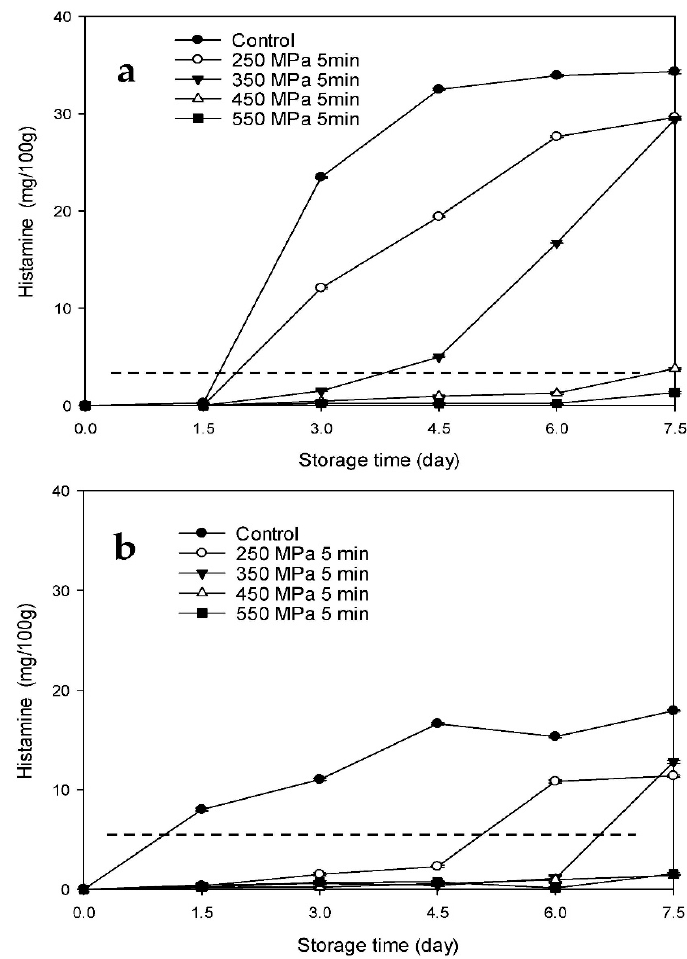
Figure 7. Changes in histamine contents of tuna meat samples inoculated with ( a ) Morganella morganii and ( b ) Photobacterium phosphoreum after high-pressure processing treatment at 250, 350, 450, and 550 MPa for 5 min during storage at 15 °C; dash line indicates the USFDA tolerance limit of 5.0 mg/100 g of histamine.